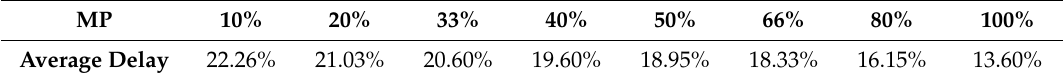
Table 4. Average delay within the segments (3-5). MP: market penetration.